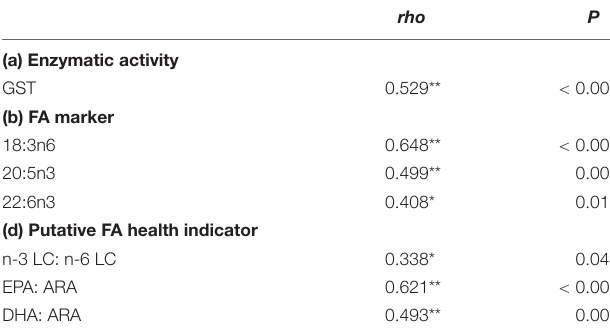
TABLE 1 | Summary of significant correlation between SD density with enzymatic activity, fatty acid marker, and putative FA health indicator from data obtained in experimental tank data. rho